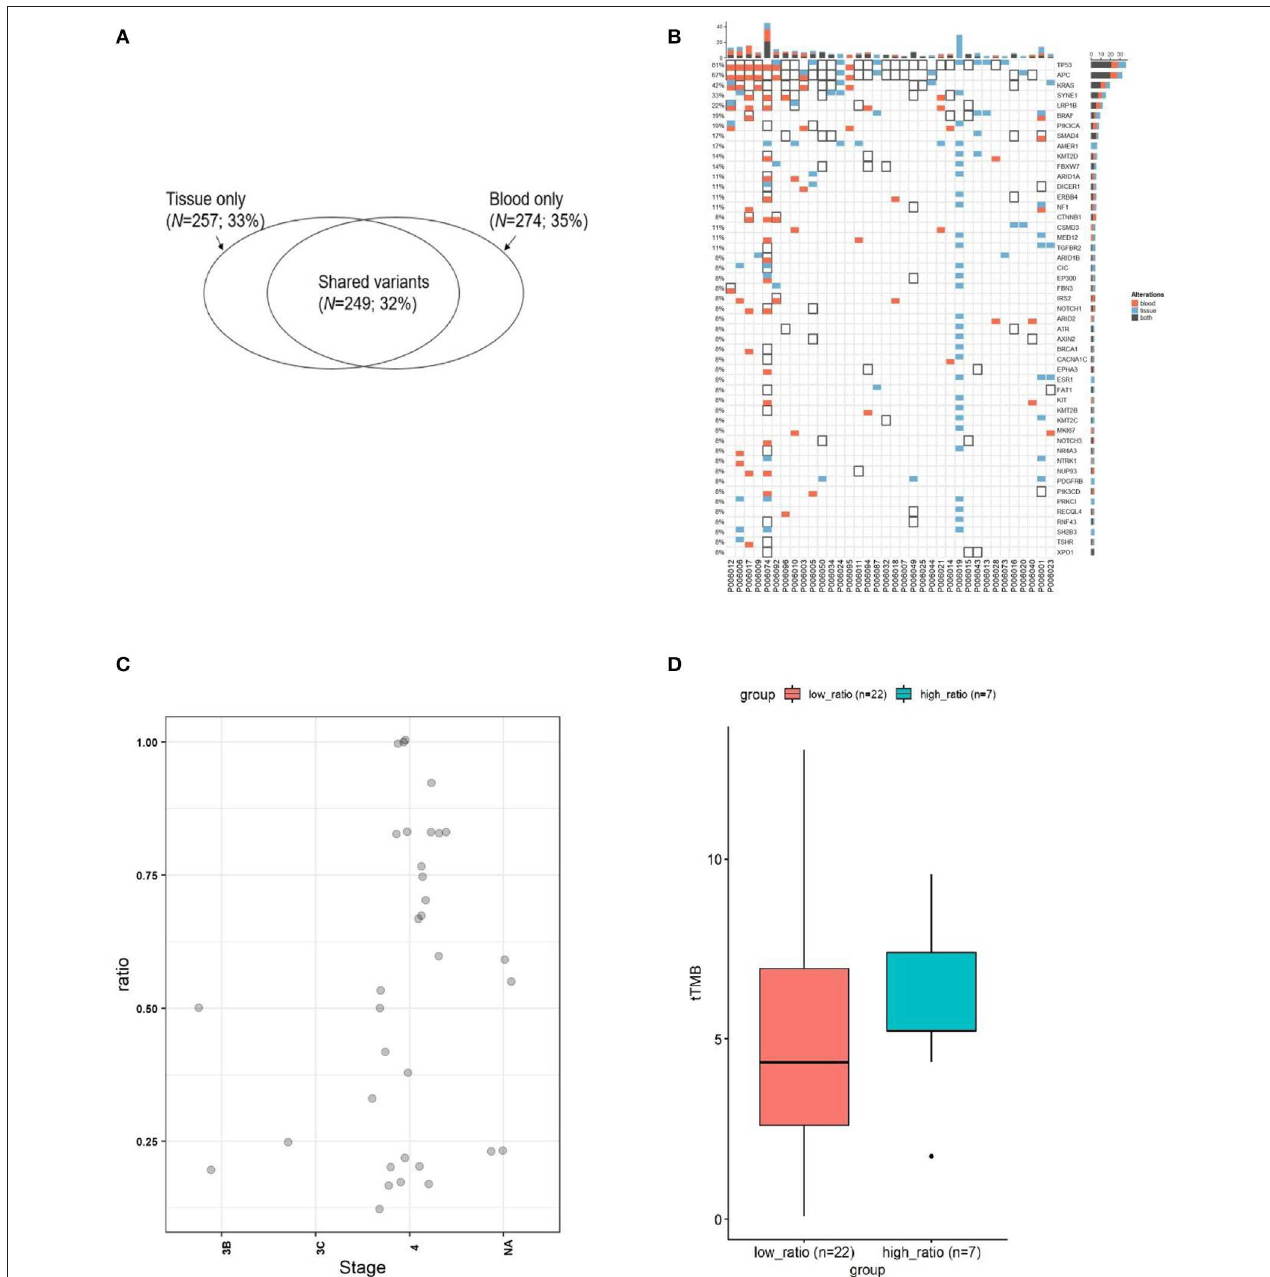
FIGURE 2 | The concordance of mutation between ctDNA and the corresponding tumor tissues from CRC. (A) Wenn diagram shows the number and percentage of overlapped and unique mutations between the tissue DNA and the corresponding blood ctDNA samples. (B) Mutation spectrum of baseline plasma and the corresponding tumor tissues from 35 subjects. (C) The mutation concordance ratio for different stages between blood ctDNA samples and tumor tissue samples from 28 patients. (D) Comparison of tumor mutation burden (TMB) in low consistency ( < 75%) and high consistency ( > 75%) groups.